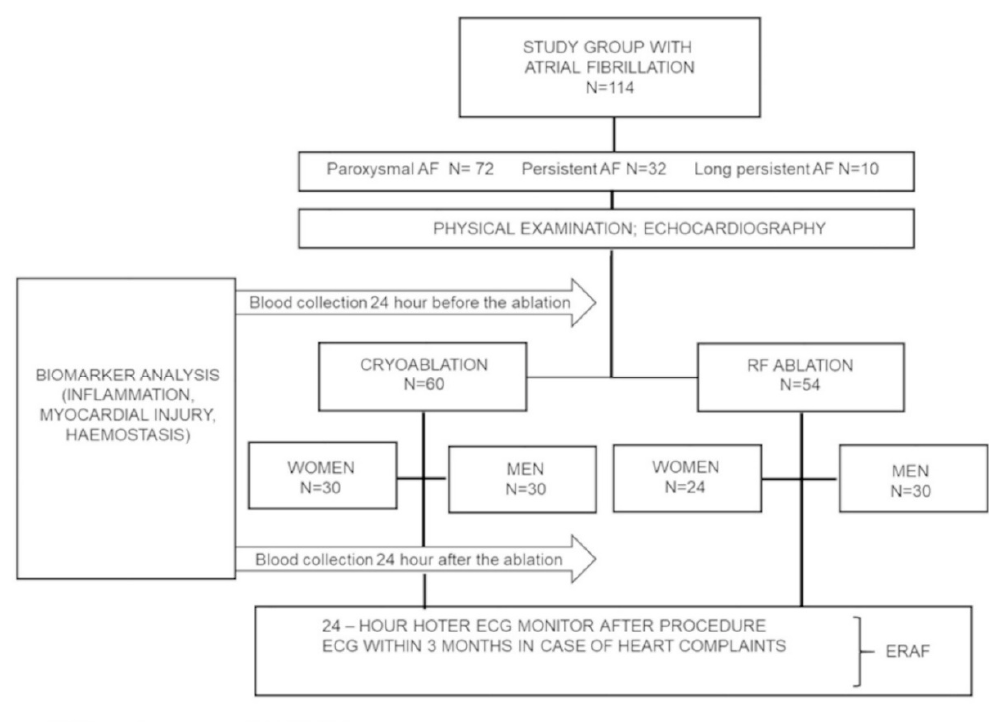
Figure 1. Flowchart of the study.